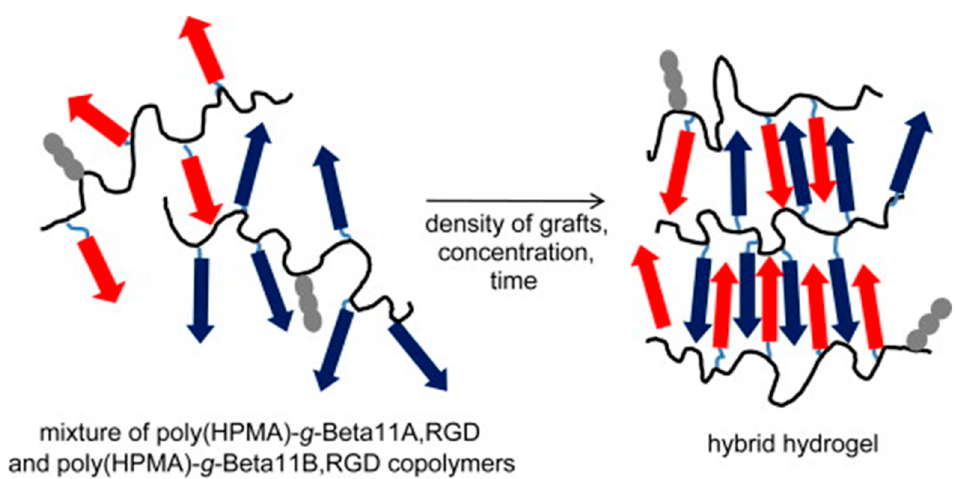
Figure 13. Hybrid hydrogel derived from the self-assembly of poly(HPMA)- g - β -sheet complementary copolymers (blue and red arrows). Grafted RGD motifs are indicated by gray fragments. Reproduced from [151]. HPMA: N -(2-hydroxypropyl)methacrylamide.